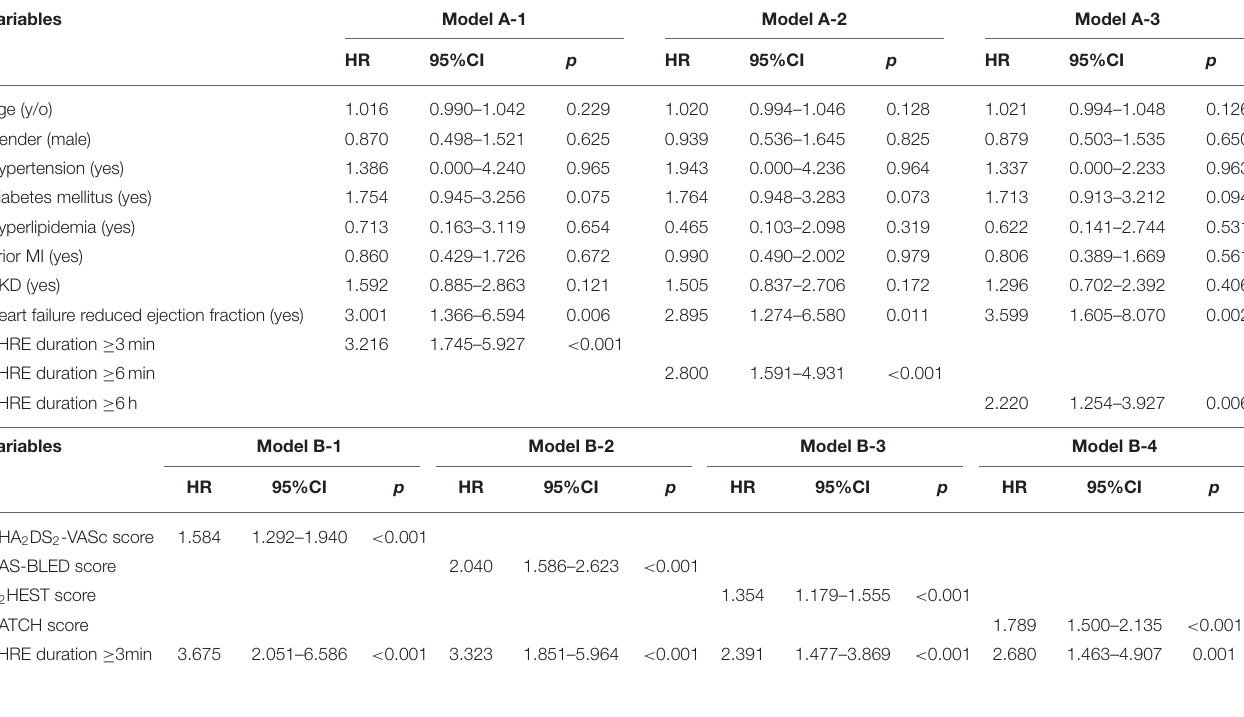
TABLE 3 | Multivariate Cox regression analysis for major adverse cardio/cerebrovascular